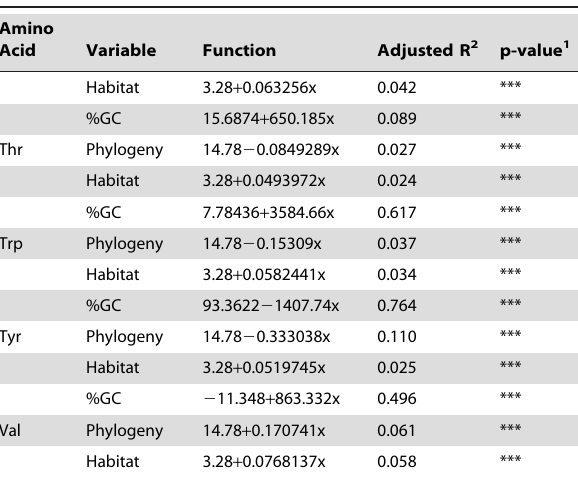
Table 3. Linear regression models for the effect of GC content, Phylogeny and Habitat on the relative cellular amino acid abundance.